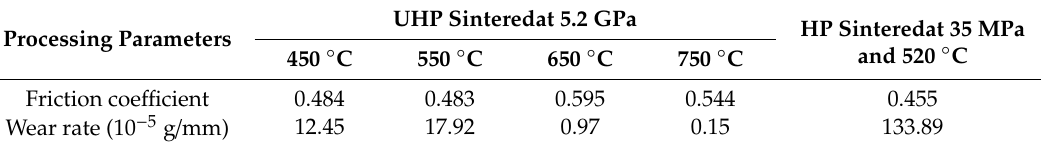
Table 2. Friction coefficients and wear rates of the G/6061Al with 10 vol.% graphite. Processing